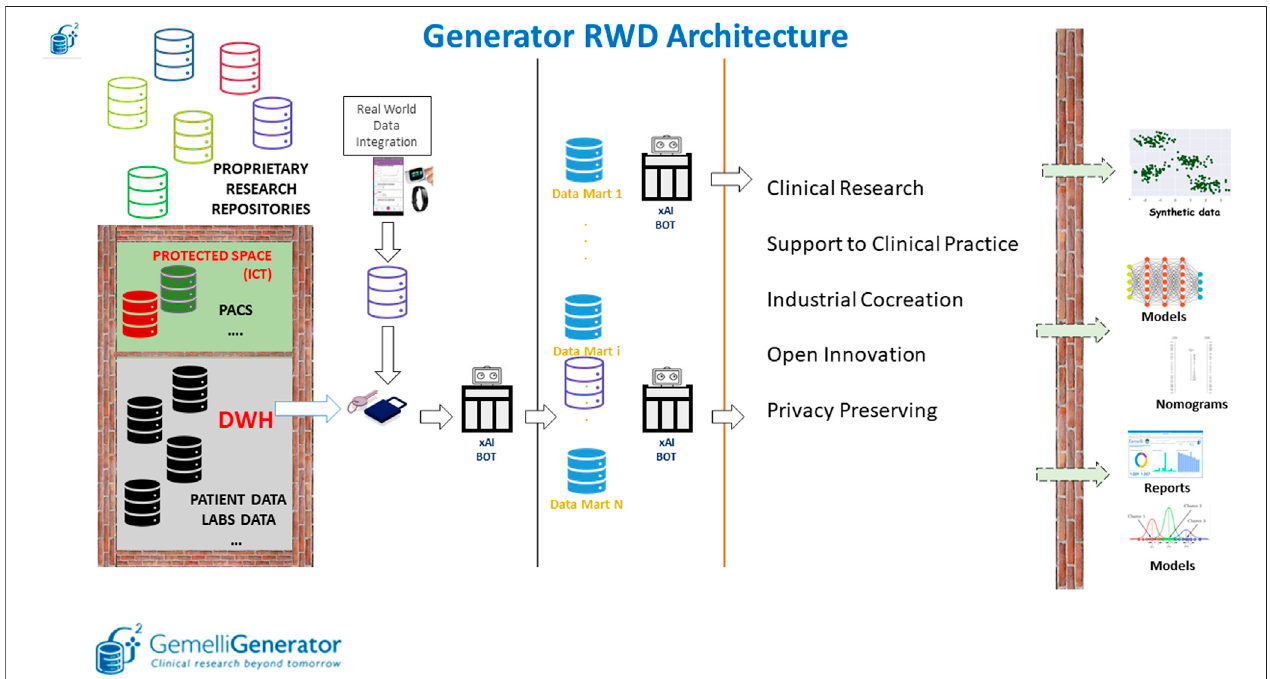
FIGURE5| OverviewoftheGeneratorRealWorldDataArchitecturecomposedofthreemainblocks:datalakelayer,dataintegrationlayeranddataanalyticslayer.